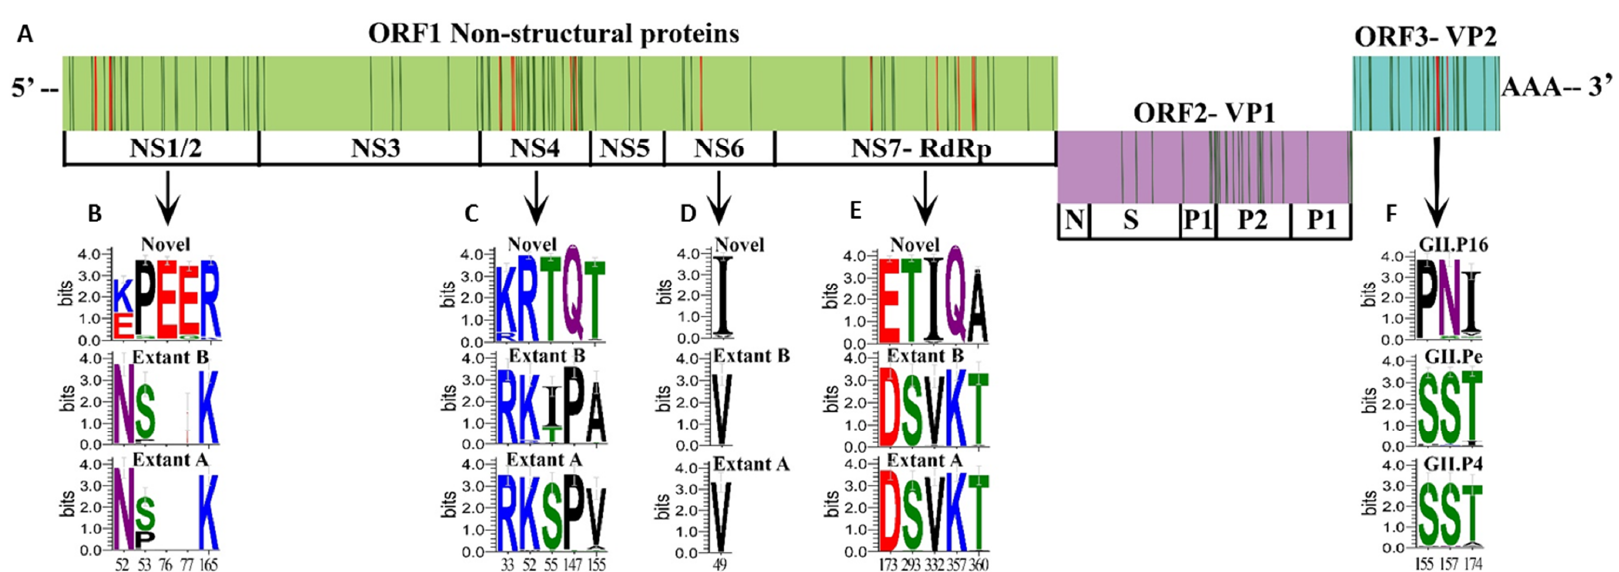
Figure 4. Informative and unique amino acid sequences detected among viruses with the novel GII.P16 polymerase. ( A ) Genomic organization of norovirus with informative sites (locations where >10% of sequences with a different polymerase type differed from those with a novel GII.P16 polymerase that emerged in 2015) are indicated with a vertical line (red, indicates changes at informative sites resulting in an amino acid that was unique to novel GII.P16 strains; green, indicates informative sites that are not unique to novel GII.P16 strains). ( B – E ) Sequence logos indicating the relative frequency of amino acid occurrence (bits) for informative sites unique to novel GII.P16 viruses within non-structural proteins when compared to Extant B and Extant A GII.P16 polymerases. Unique informative sites shown for ( B ) NS1/2, ( C ) NS4, ( D ) NS6, ( E ) NS7. ( F ) Sequence logos of informative sites unique to novel GII.P16-GII.4 Sydney viruses within VP2 when compared to GII.4 Sydney viruses with GII.Pe and GII.P4 New Orleans polymerases. Bottom numbers indicate amino acid position within each protein.